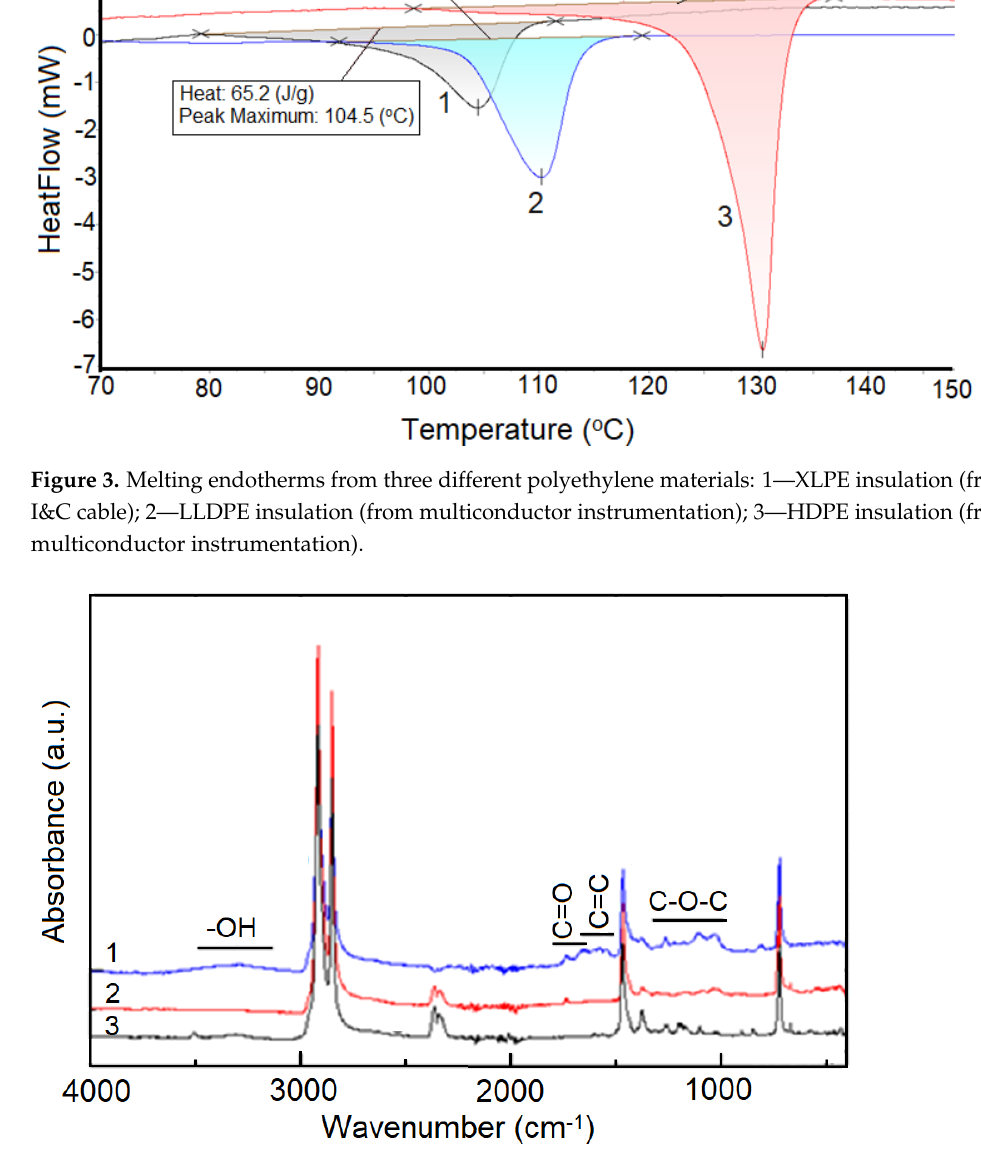
Figure 4. Typical ATR-FTIR spectra obtained on LDPE-based materials (HV cable): 1 — Sheath, outer part (visually shows traces of photo-oxidation, i.e., color change); 2 — sheath, inner part; 3 — insula- tion.